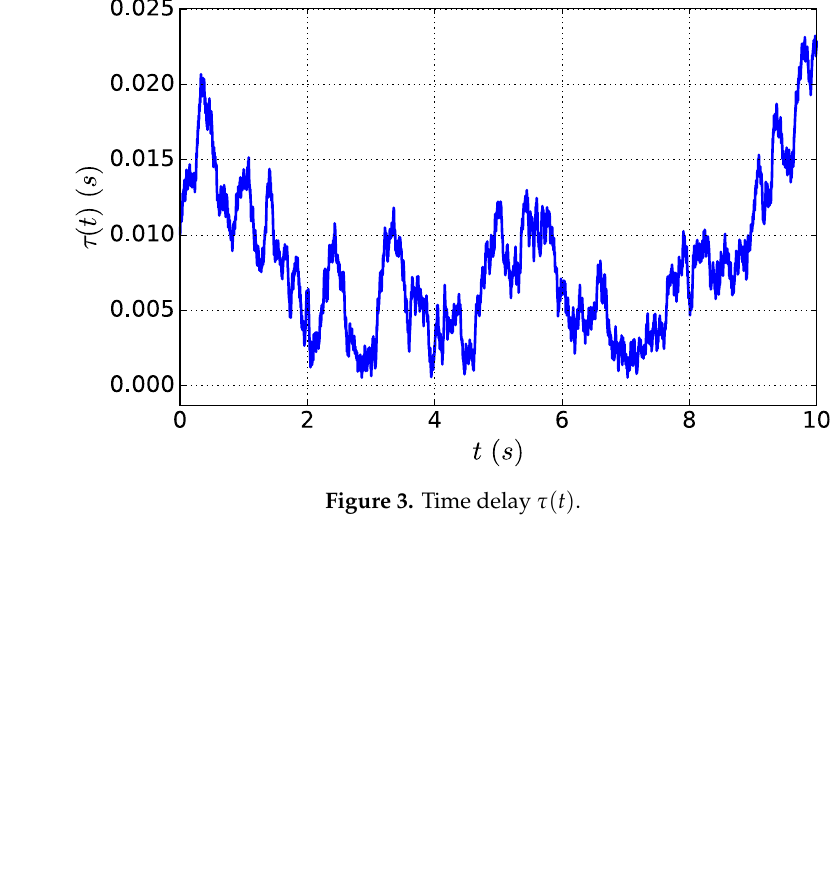
Figure 4. Factor 𝐹(𝑡) for parameter uncertainties.